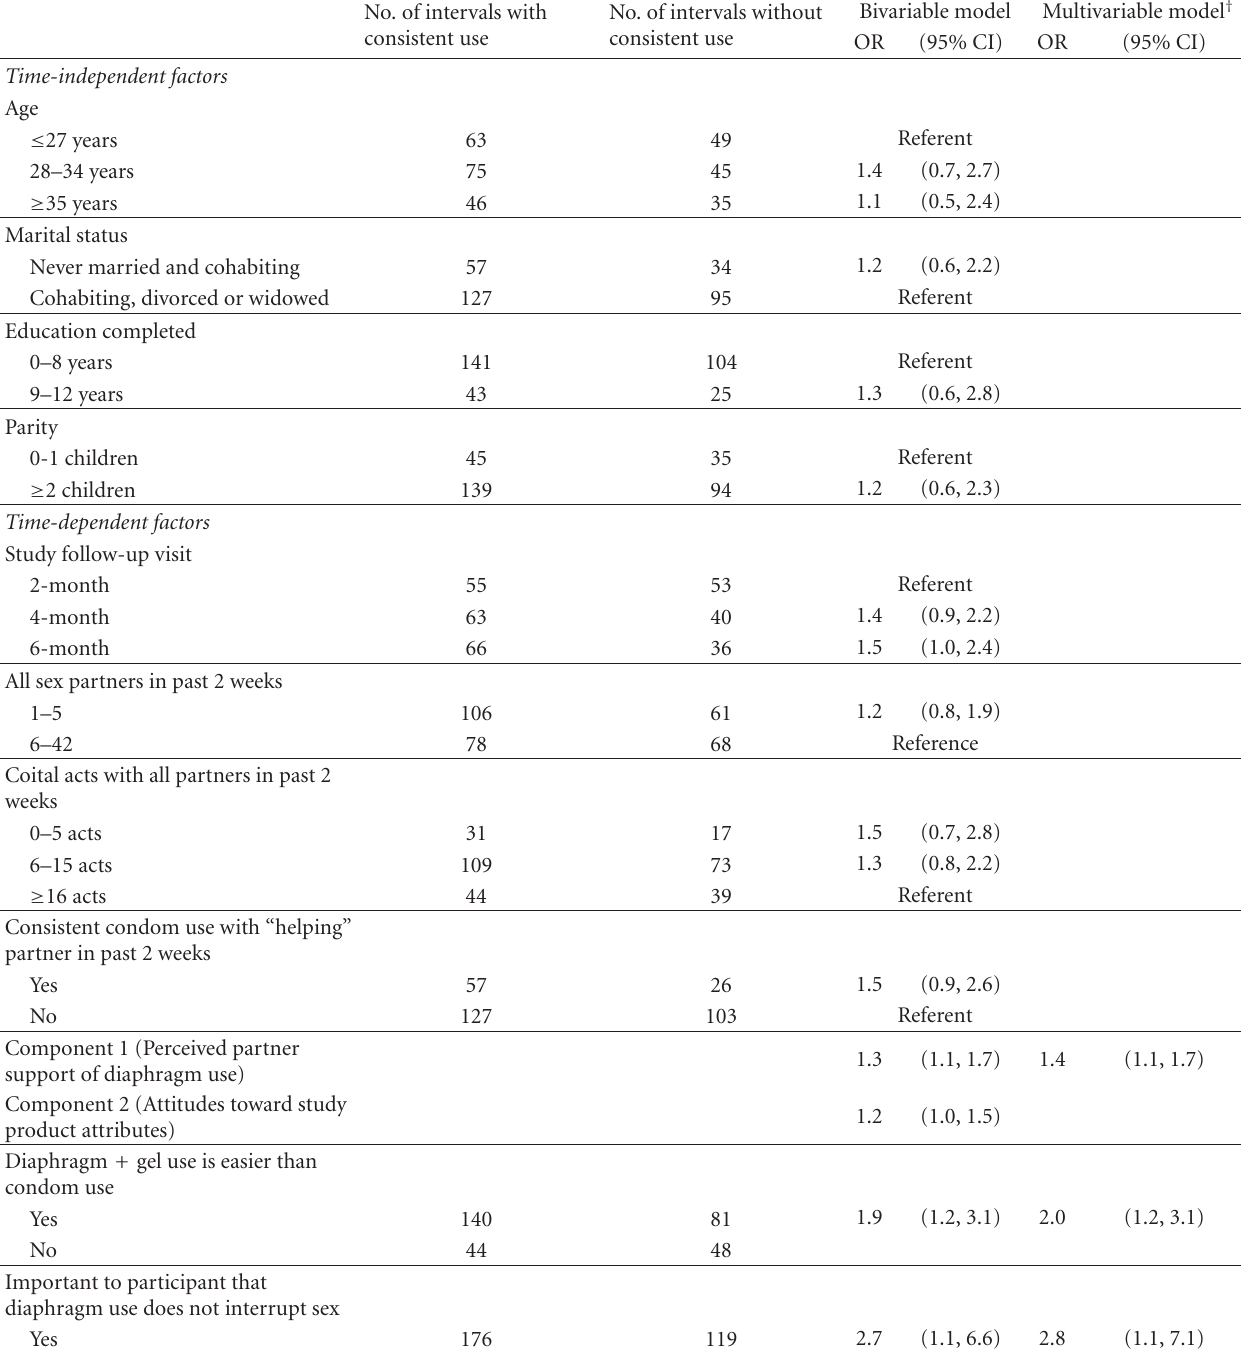
Table 3: Associations between consistent diaphragm use with “helping” partner during previous 2 weeks and selected demographic characteristics and attitudes toward diaphragm use, Nairobi, Kenya, 2004-2005 ∗